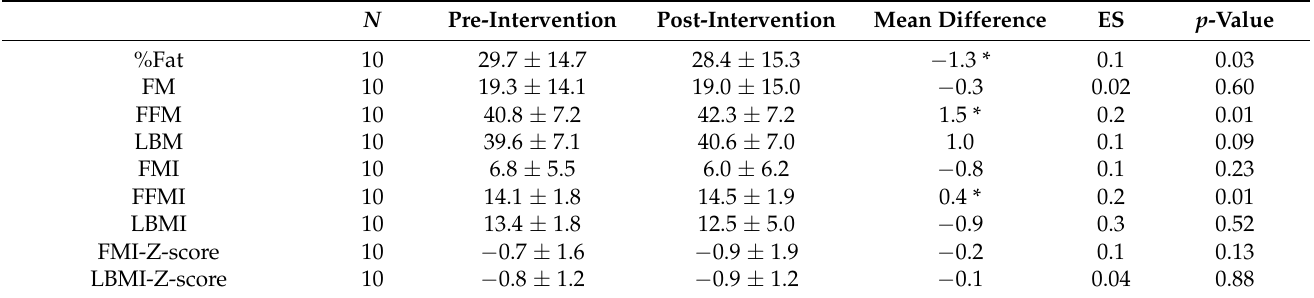
Table 4. Body composition pre-post